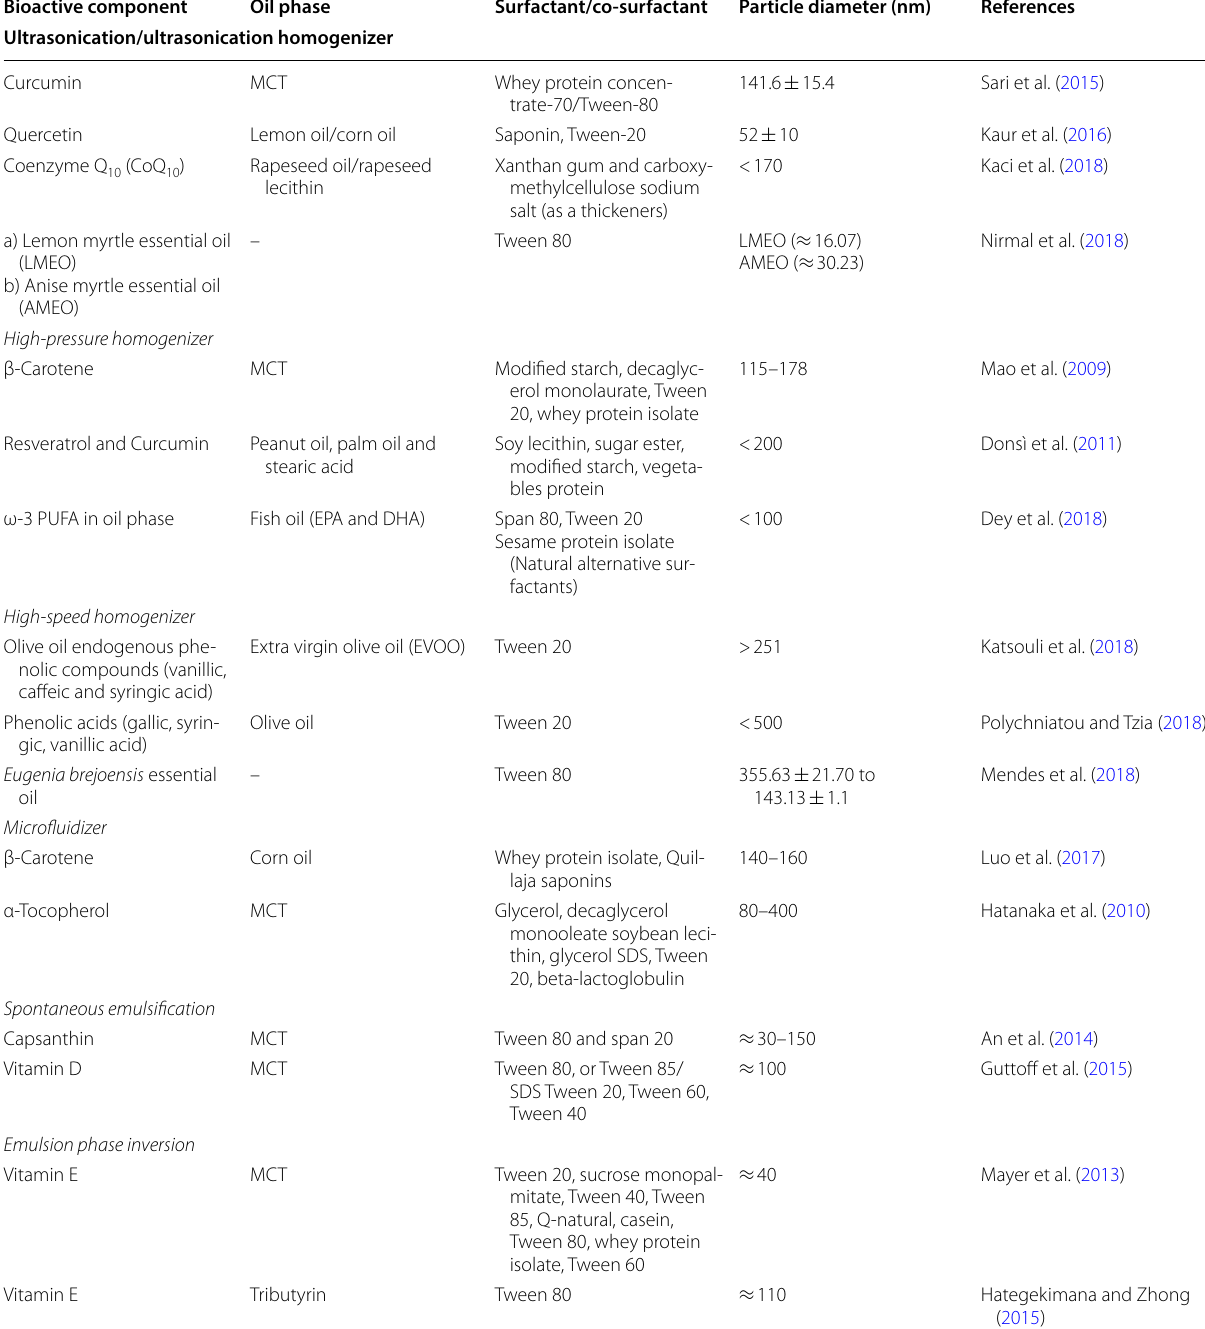
Table 3 Examples of oil‑in‑water nanoemulsions by using different methods Bioactive